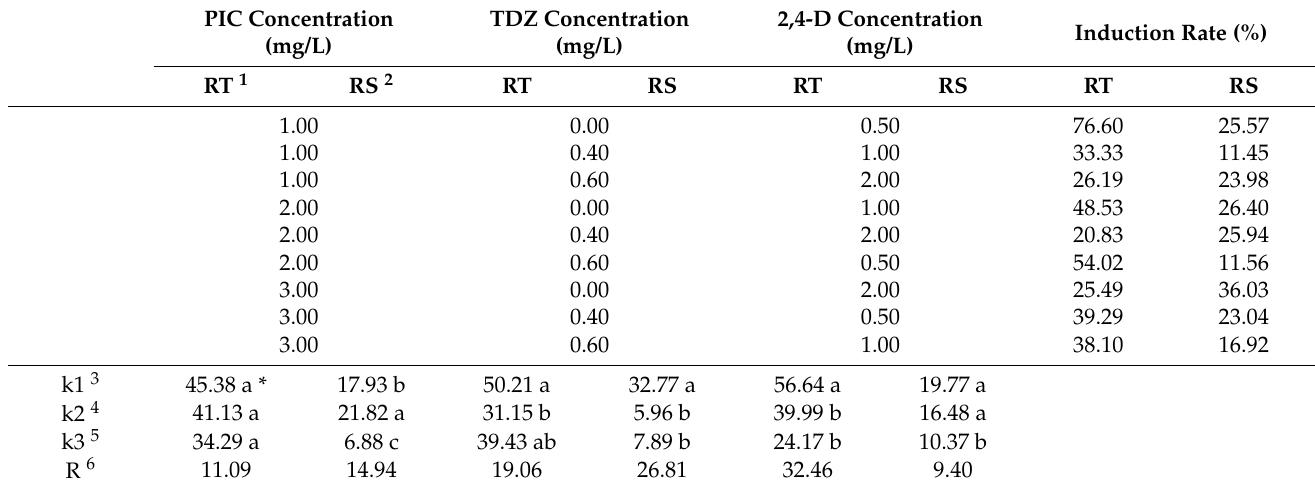
Table 2. Effects of combination of PIC, TDZ and 2,4-D on callus induction from A. praecox